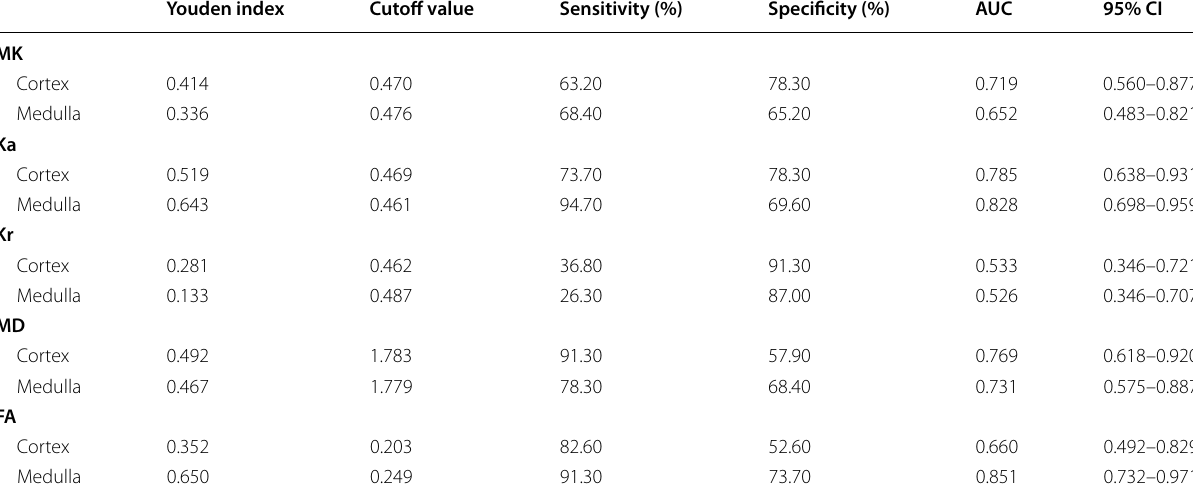
AUC area under the receiver operating characteristic curve, CI confidence interval